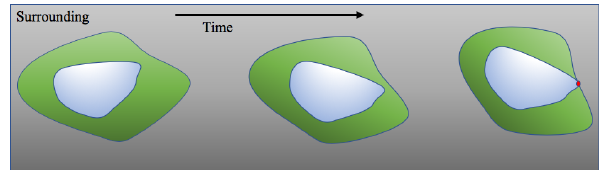
Figure 5. The dynamic of two coherent sets. As the inner set con- tacts the boundary of the outer one, it gives the chance for new re- actions that may cause a critical